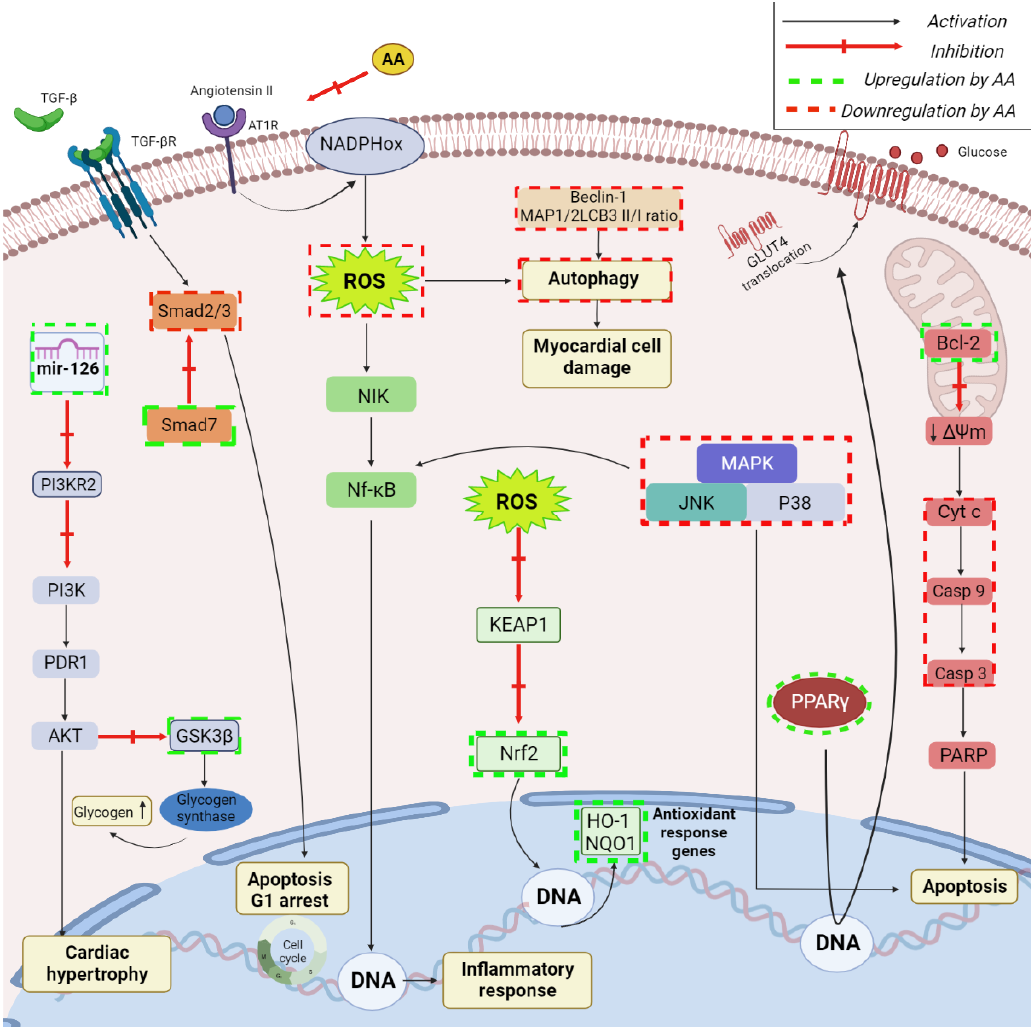
Figure 7. Schematic representation of the reported cardioprotective mechanisms of AA; key signal- ing pathways targeted by AA in neurodegeneration: MAPK/mitochondria-dependent apoptotic pathway inhibition -> antioxidant effect; Akt/GSK-3β-mir-126 mediated signaling pathway activa- tion -> reduces myocardial hypertrophy; TGF-β1/Smad2/3 phosphorylation inhibition -> reduces myocardial hypertrophy; increasing the expression of Nrf2, HO-1, and NQO-1 -> antioxidant effect; Ang II-AT1R-NADPH oxidase-NF-κB pathway inhibition -> anti-inflammatory effect. Created with BioRender.com (accessed on 8 May 2022).